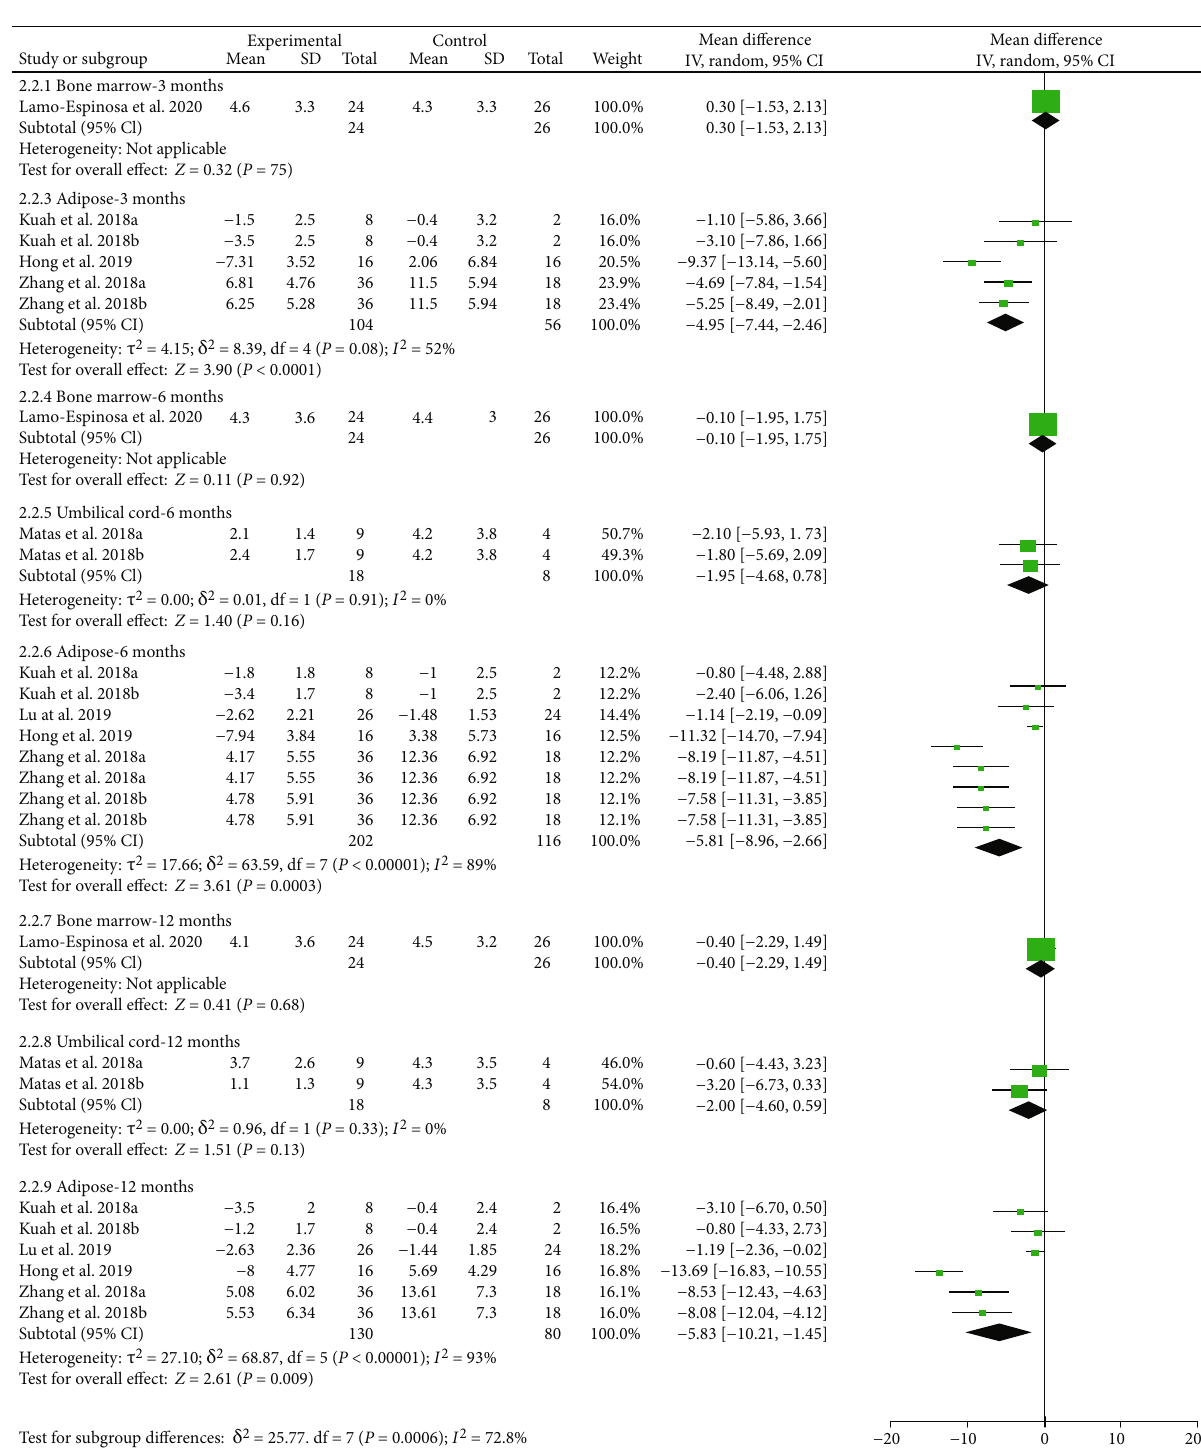
Figure 9: WOMAC pain-di ff erent cell